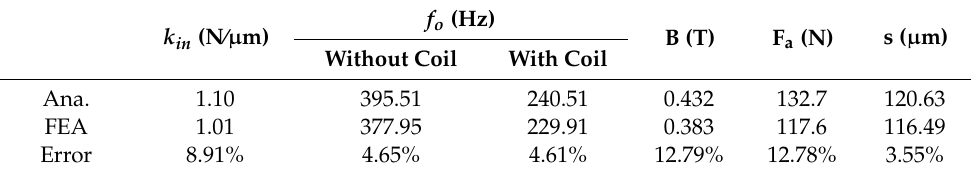
Figure 4. Distribution of the magnetic flux density obtained by finite element analysis (FEA). Table 4. The analytical and FEA results of the FTS.